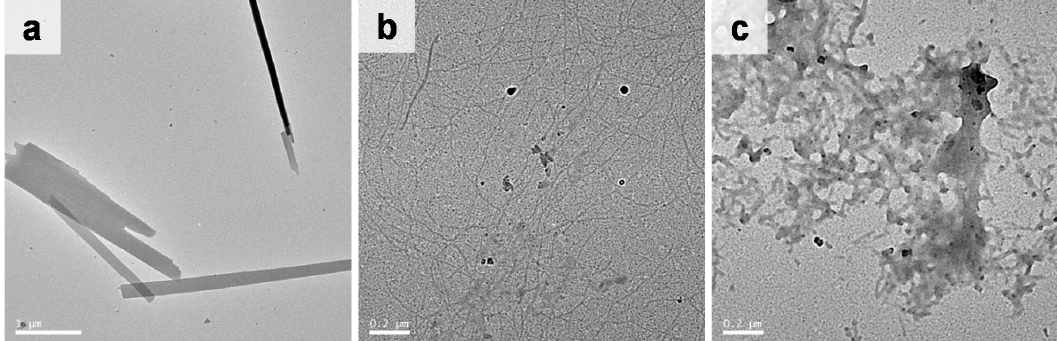
Figure 5. Representative TEM images of ( a ) β Gal–AAC–C6–F2, ( b ) β Gal–AAC–C6–F3, and ( c ) β Gal–AAC–C6–F4 samples after being transferred onto elastic carbon-coated grids and dried in vacuo. Conditions: [ β Gal–AAC–C6–F2] = 2.4 wt% (CGC), [ β Gal–AAC–C6–F3] = 0.19 wt% (CGC), and [ β Gal–AAC–C6–F4] = 0.35 wt%, 200 mM HEPES–NaOH buffer (pH 8.0).